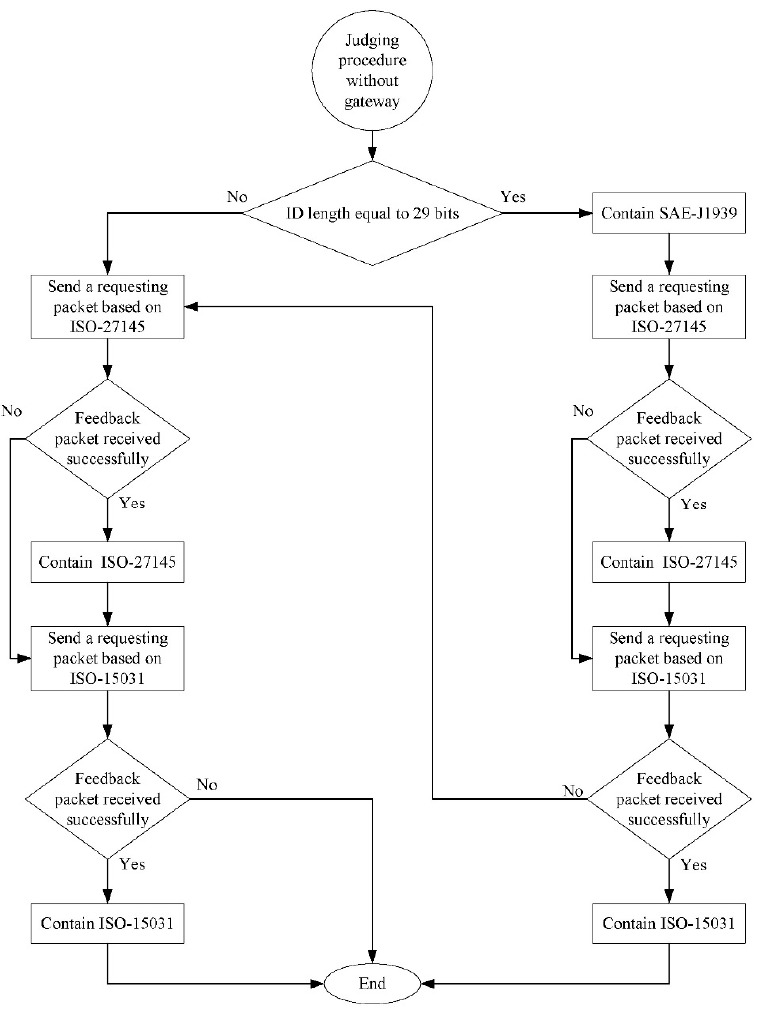
Figure 4. CAN bus communication protocol identification without